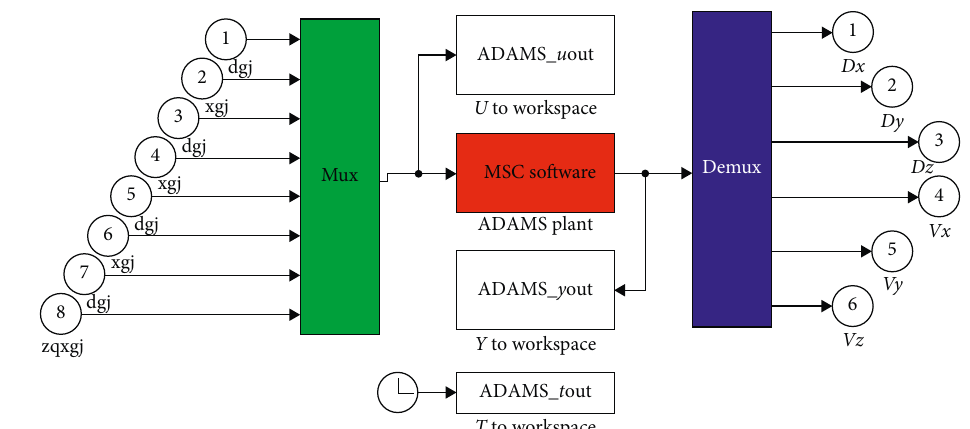
Figure 7: ADAMS multibody dynamics